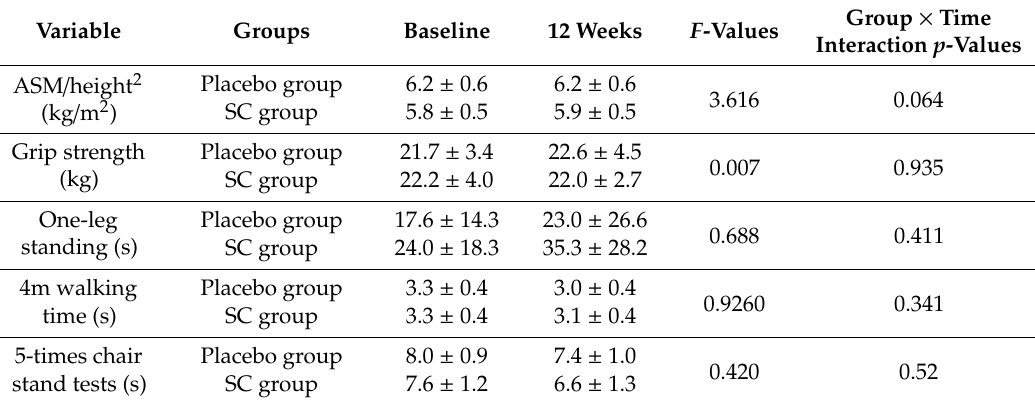
Table 2. Comparisons of appendicular skeletal mass and physical performance variables at baseline and at 12 weeks, after age